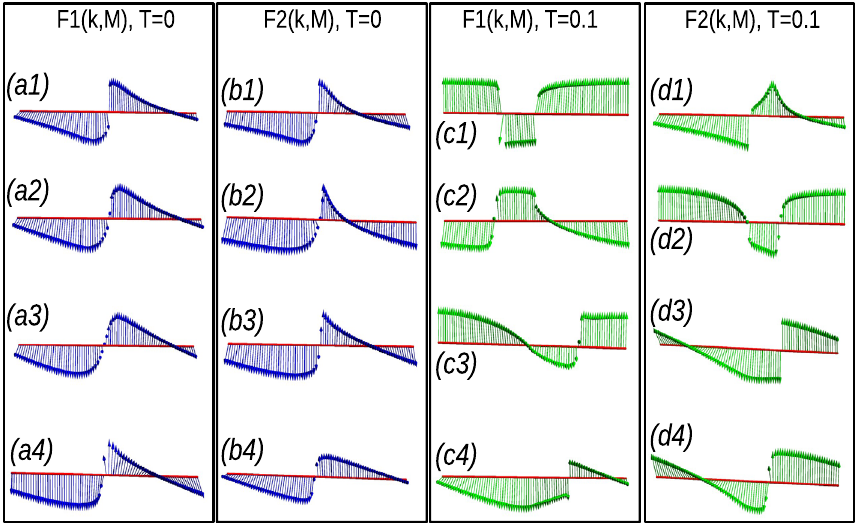
Figure 9. (Color online) Winding vectors representing the topological phases at Zero temperature (using Eq. (36)) and at a small arbitrary temperature T